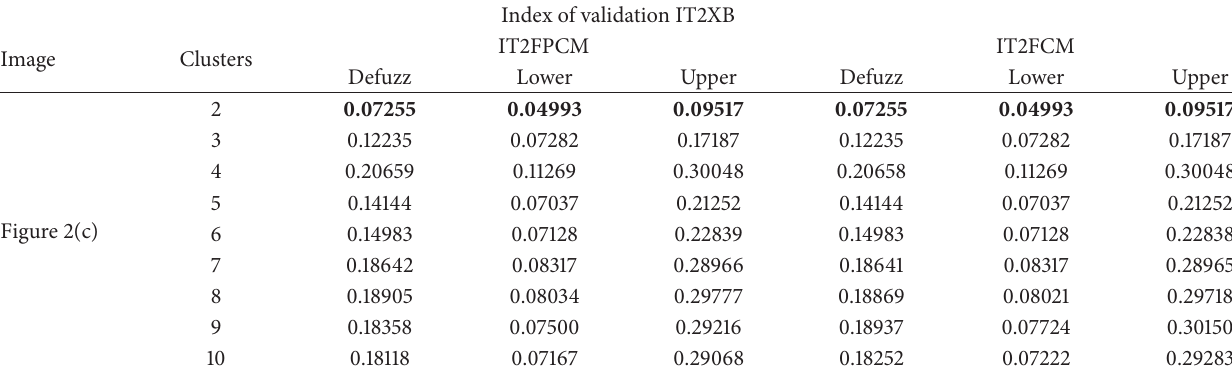
Table 35: Results of the IT2XB validation index to the clustering of image shown in Figure 2(c) using IT2FPCM and IT2FCM algorithm with 𝑚 = [1.5, 2.5] and 𝜂 = [1.5, 2.5] as parameters.